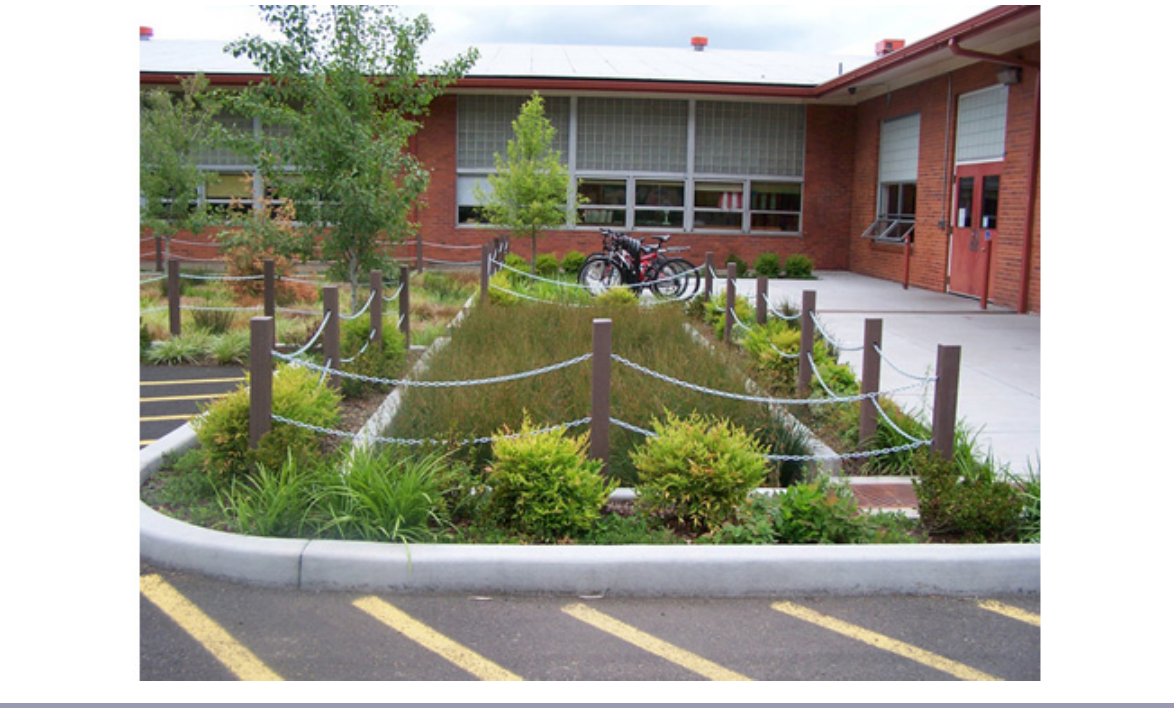
Figure 3. A raingarden that is designed to treat and infiltrate stormwater from the rooftop and parking lot of Mount Tabor Middle School in Portland, Oregon, also serves an educational